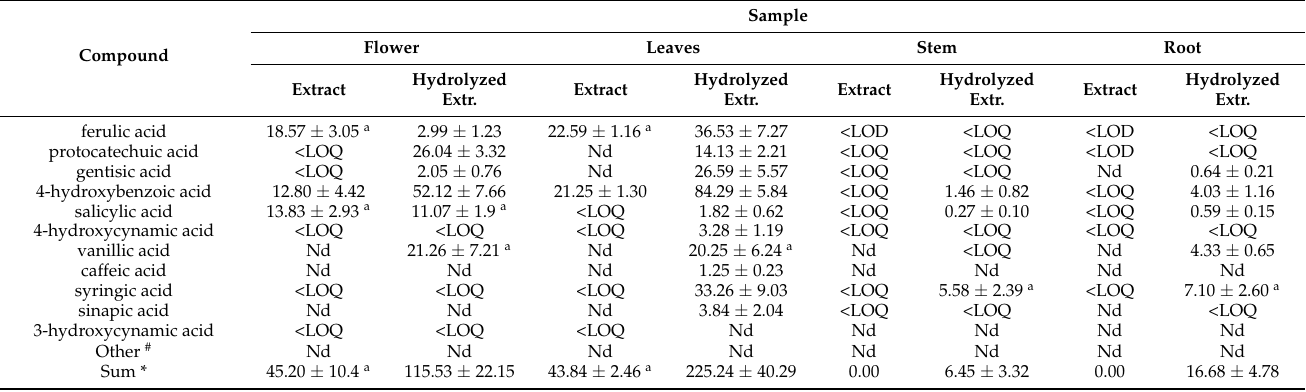
Table 1. Phenolic acid content in different morphological parts of Atriplex sagittata Borkh. before and after acidic hydrolysis [ µ g/g dw. ±